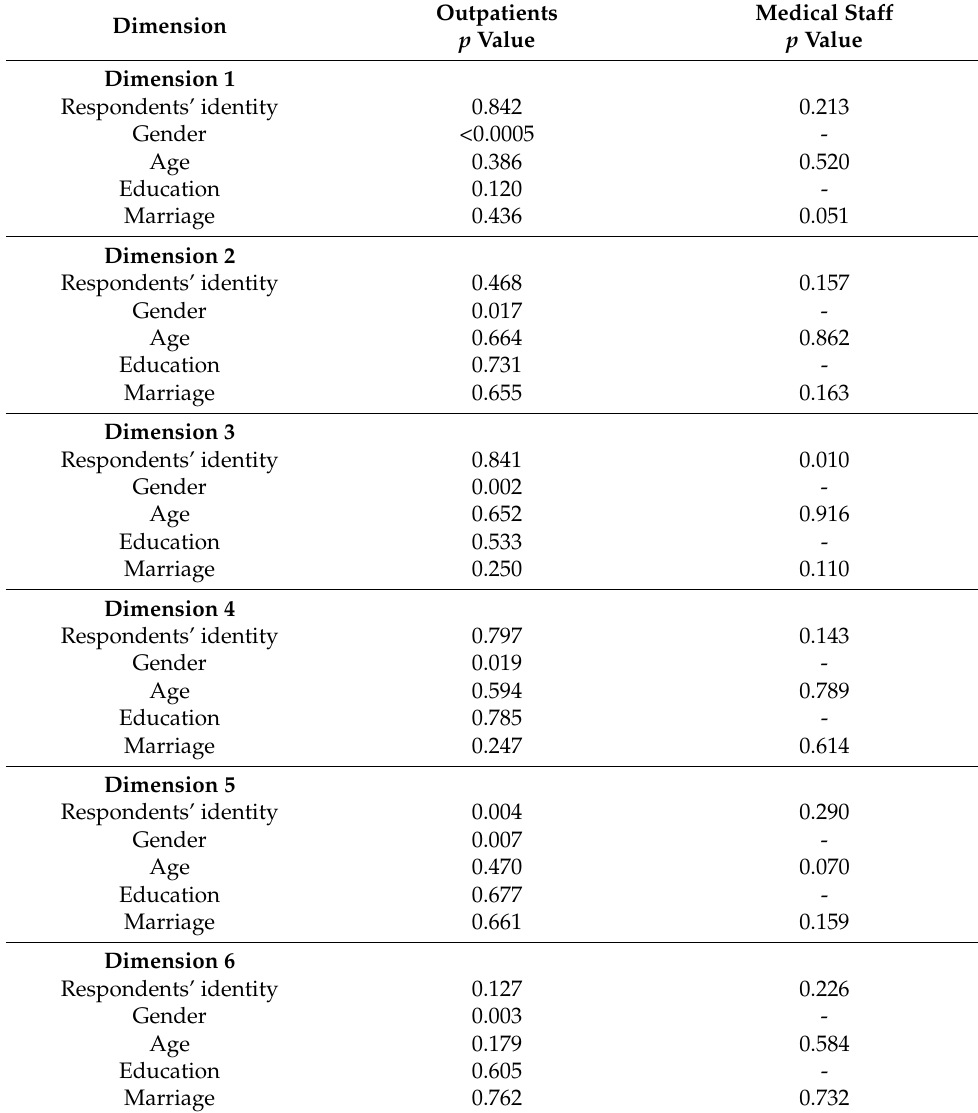
Table 4. Analysis of variance for respondents’ identity, gender, age, education, and marriage.